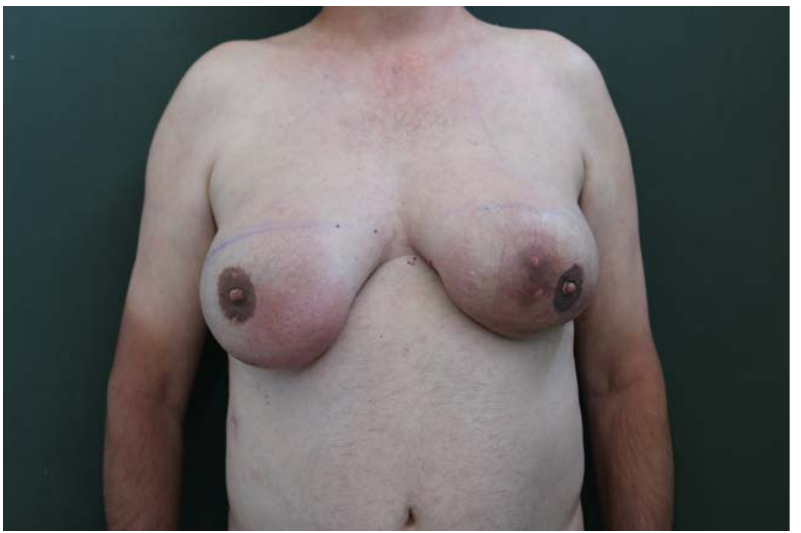
Figure 1. Grade 4 bilateral gynecomastia (according to Rohrich classification) with an asymmetric development of the glands.